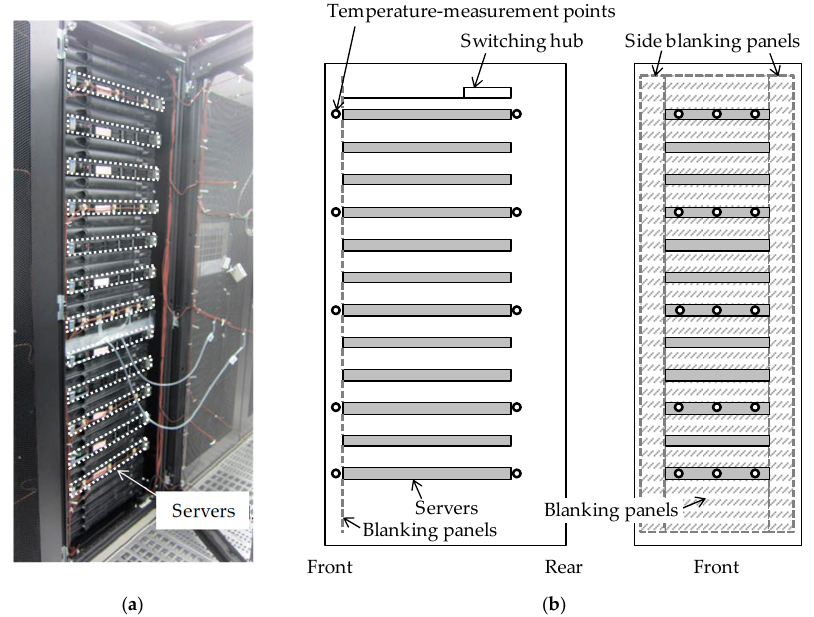
Figure 3. Server installation status and temperature-measurement points of target rack: ( a ) Equipment mounting (with blanking panels) and ( b ) locations of temperature measurement.